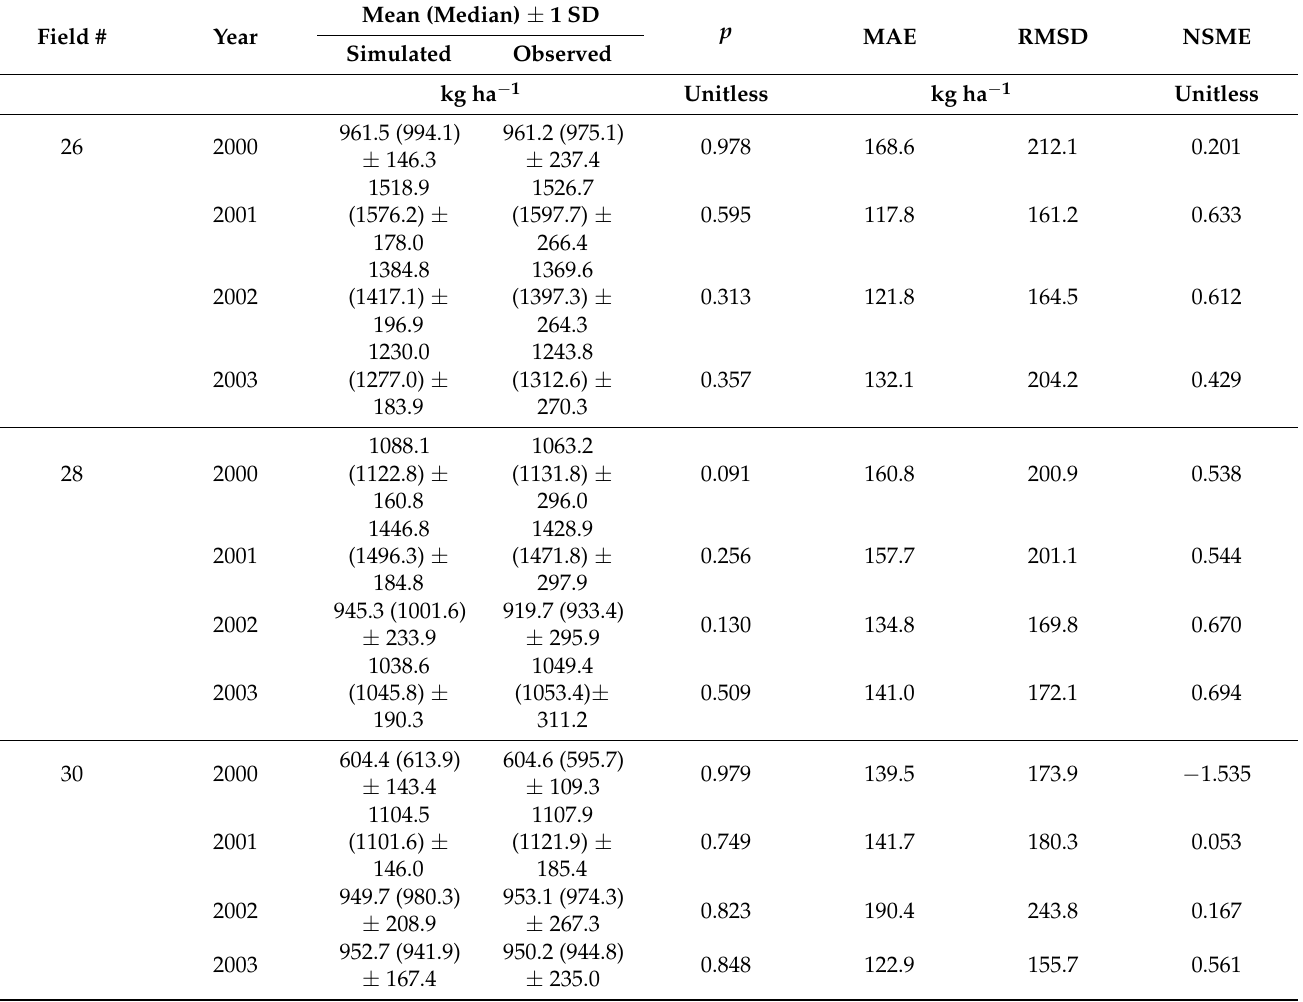
Table 2. Comparison statistics of p ( t -test at α = 0.05), mean absolute error (MAE), root mean square deviation (RMSD) and Nash–Sutcliffe model efficiency (NSME) for the simulated and observed cotton yields of the fields #26, #28, and